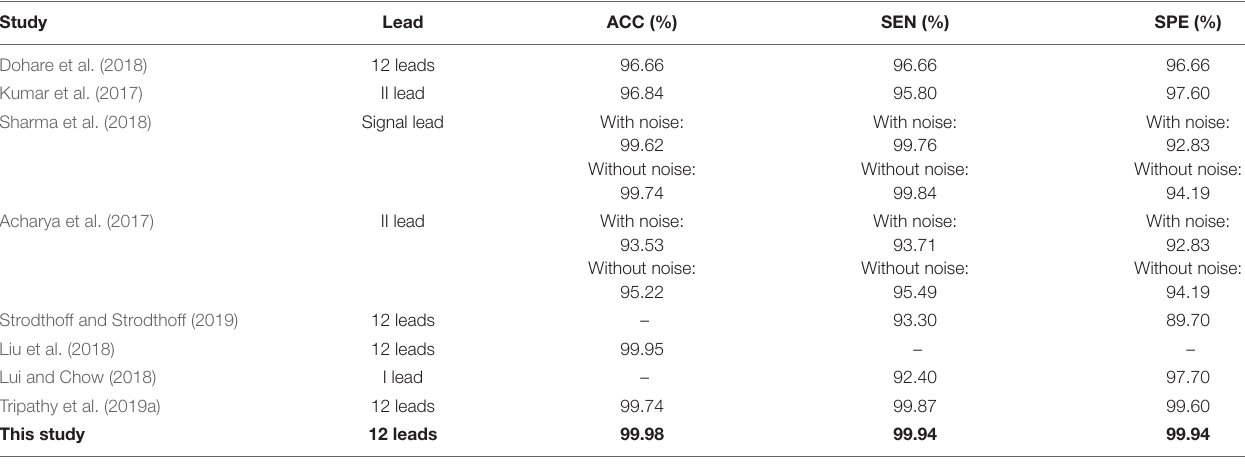
TABLE 6 | Comparison of MI detection results from this study with other recent reports.